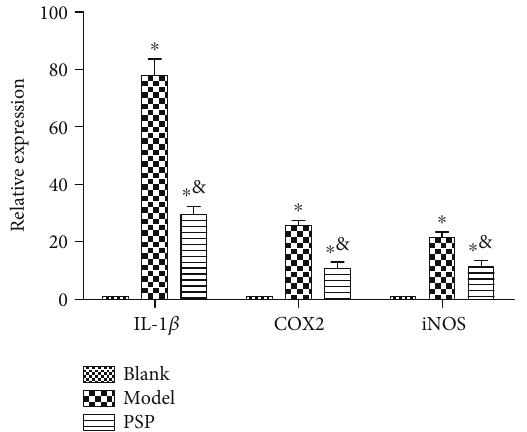
Figure 5: Protective e ff ect of PSP on in fl ammation of rats with degeneration of the intervertebral disc. ∗ P < 0 05 , compared with the blank group. & P < 0 05 , compared with the model group.